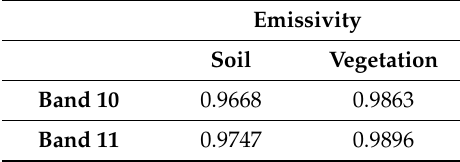
Table 4. Emissivity of soil and vegetation for Landsat 8 thermal infrared sensor bands 10 and